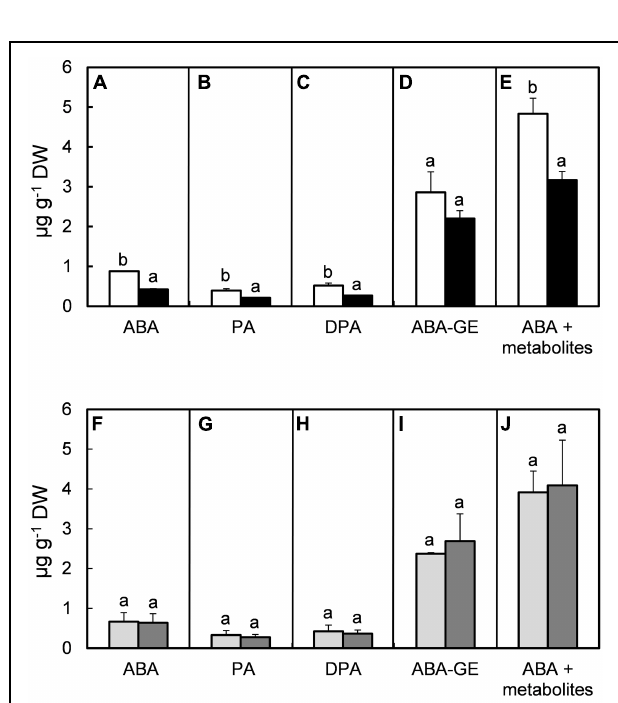
FIGURE 4 | Effect of moderate (61%; open columns) and high (92%; solid columns) RH (A–E), combined with no additional MOV (light gray columns) or with additional MOV (gray columns; F–J) on the levels ( µ g g -1 DW) of ABA (A,F), PA (B,G), DPA (C,H), ABA-GE (D,I) and total concentration of ABA and its metabolites (E,J) in leaves of rose plants cv. ‘Toril.’ Sampling occurred 5 h after the beginning of the light period. Each sample consisted of a composite of seven leaflets from seven biological replicates. Values are the mean of two biological repeats and bars represent the SEM. Different letters indicate significant differences according to Fisher’s LSD test ( P = 0.05).